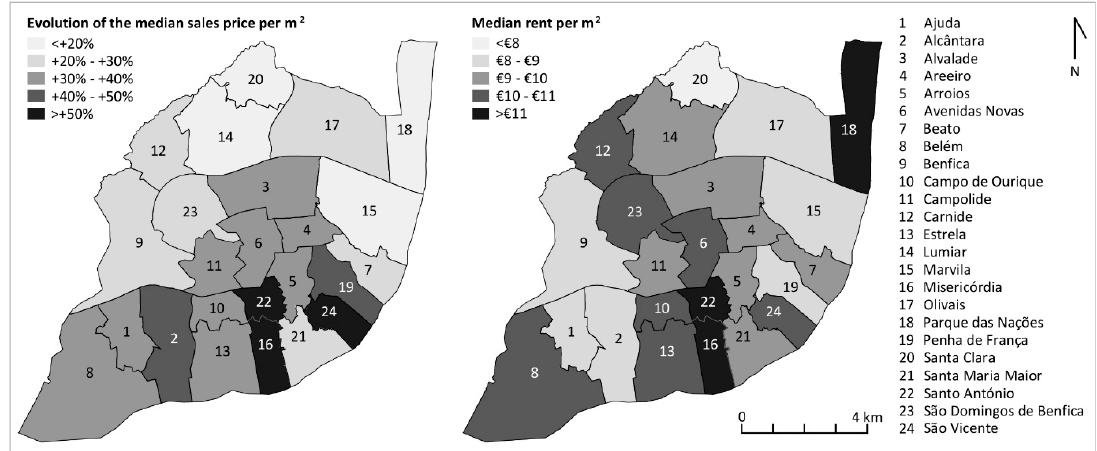
Figure 4. Evolution of the median sales price per m 2 of family dwellings between the first quarter of 2016 and the fourth quarter of 2017 ( left ) and median rent per m 2 of new lease contracts of family dwellings in 2017 ( right ). Source : Own elaboration based on Instituto Nacional de Estatística (2018c, 2018d).